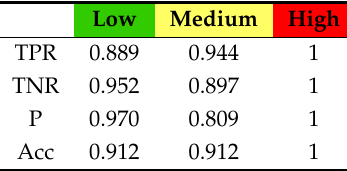
Table 11. Values of the metrics TPR, TNR, Precision and Accuracy based on Table